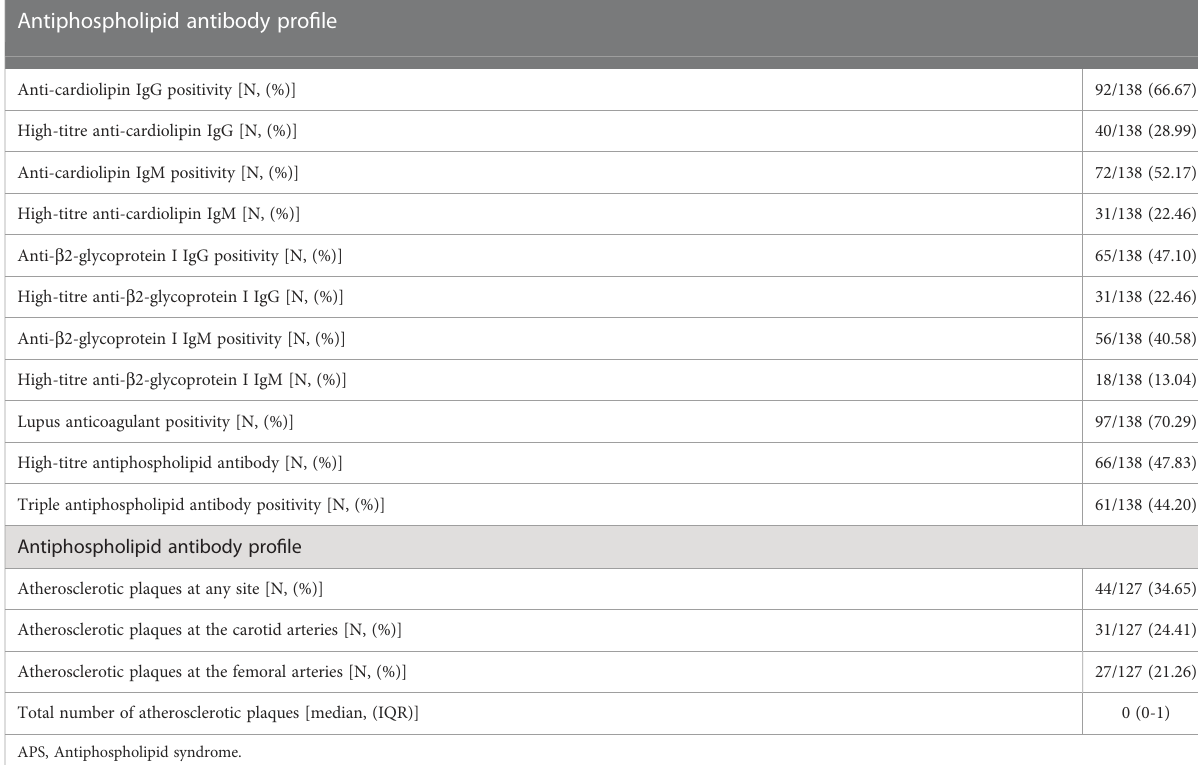
TABLE 2 Antiphospholipid antibody pro fi le and vascular ultrasound characteristics of APS patients (excluding APS patients with known diabetes mellitus). Antiphospholipid antibody pro fi le